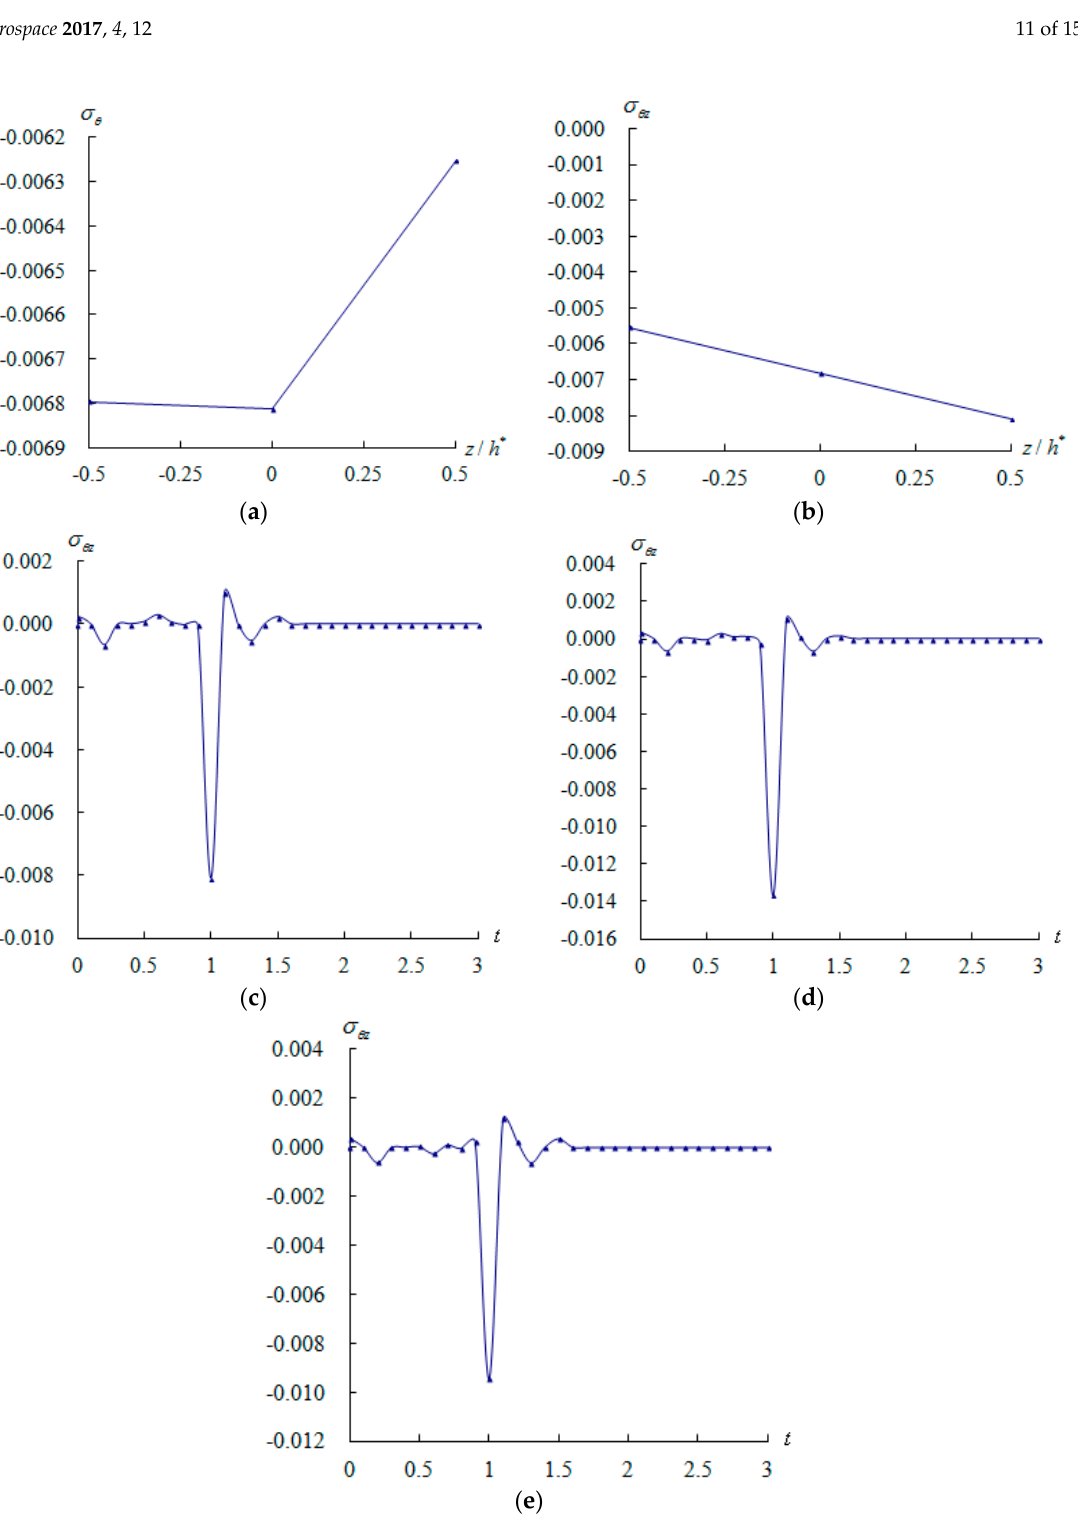
Figure 5. Stresses versus * / hz and t for 2 = ∞ M , 4 and 10: ( a ) θ t = 1.0 s; ( b ) σ θ z (GP a ) versus z / h ∗ for M ∞ = 2 at t = 1.0 s; ( c ) σ θ z (GP a ) versus t (s) for M ∞ = 2; ( d ) σ θ z (GP a ) versus t (s) for M ∞ = 4; ( e ) σ θ z (GP a ) versus t (s) for M ∞ = 10. The amplitudes w ( L /2, 2 π /2 ) (unit mm) versus T (unit K) and R n values (from 0.1 to 10)